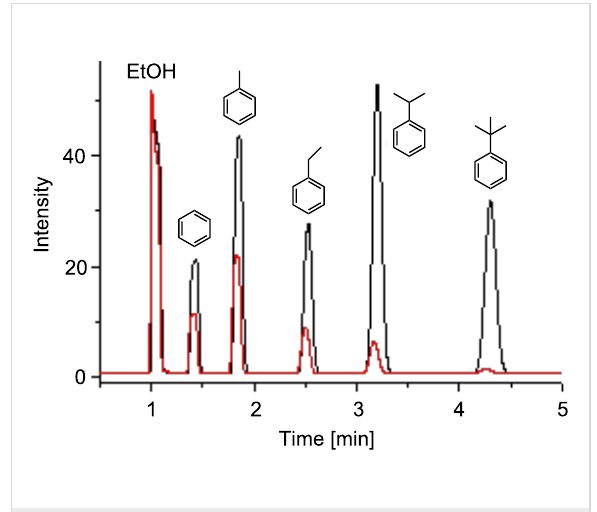
Figure 3: Chromatogram obtained by HS-GC for a mixture of aromatic guests (1 ppm) in water (black) and 10 mM solution of β -CD 1 (red).